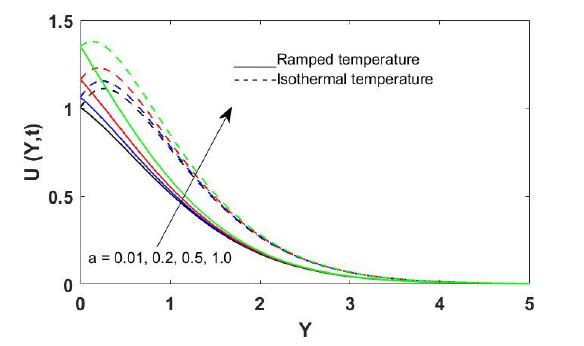
Figure 9: Momentum distribution versus a t=0.3, R=0.2, S=1, K=1, Gc=4 The effect of the heat absorption parameter Q on mo- mentum distribution for ramped wall temperature and isothermal wall temperature is depicted in Figure 3. The absorption of heat from a region’s surface is referred